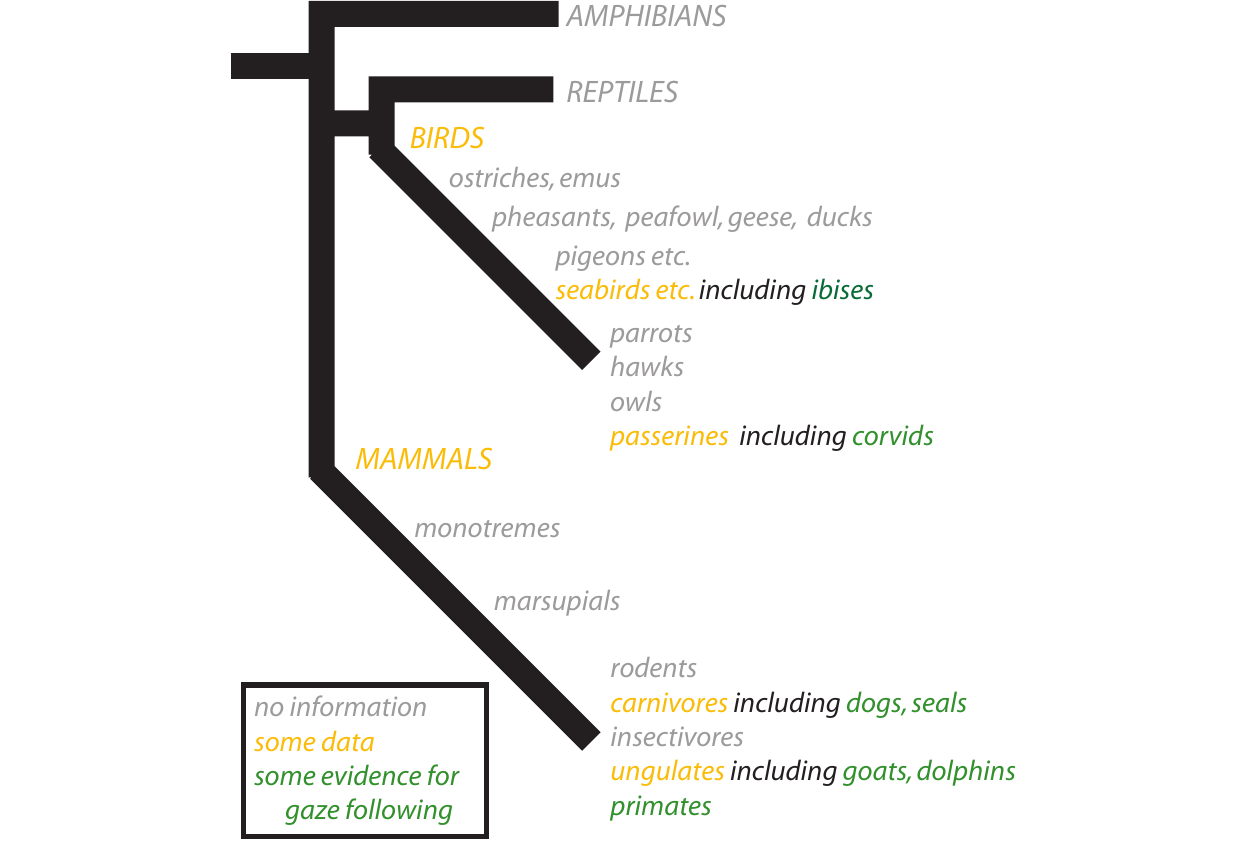
including dolphins and seals, and birds including corvids and ibises. Better understanding of the evolution of gaze behavior will require more comparative studies, with a particular eye toward distinguishing both the sophistication and species-specificity of gaze cue